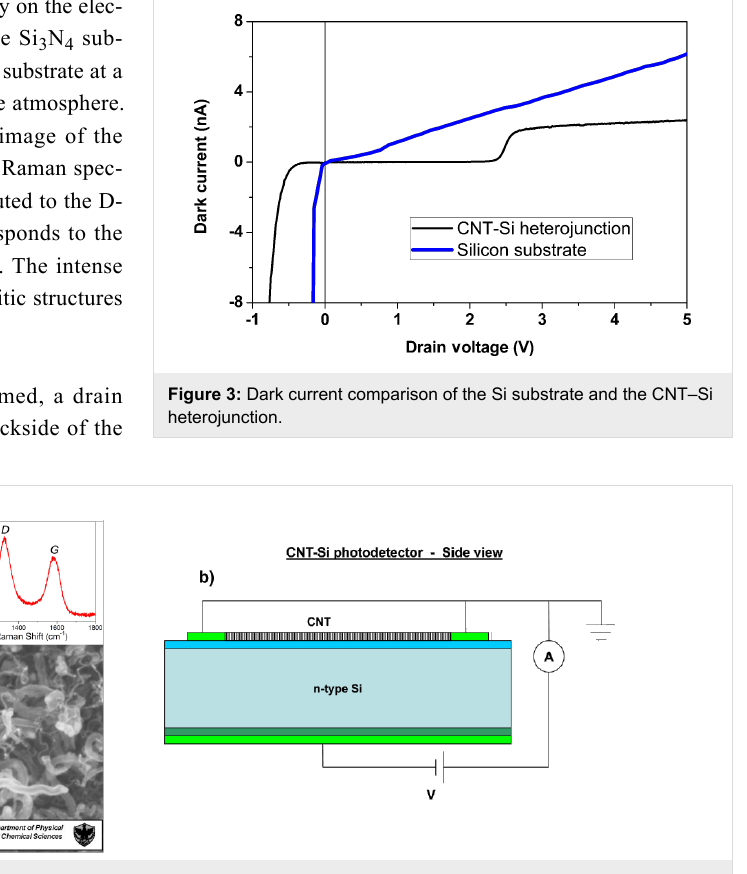
metallic guard ring, 1 mm wide, serves to inhibit superficial current dispersions during electrical measurements. In the bottom part of the silicon wafer, a thin n + implanted layer ensures ohmic contact between the silicon and the metallic Ti/Pt electrodes, covering the entire back surface (Figure 1b). Thus, the main differences between the FBK substrate used in this work and the substrate used in [13] are: the Si 3 N 4 insulation layer on the upper part of the Si is much thinner (60 nm instead of 140 nm), the different thickness of Si (300 μ m instead of 500 μ m), the different Si resistivity (3–12 Ω∙ cm instead of 40 Ω∙ cm) and the absence of a Si 3 N 4 insulating layer in the bottom part of the Si layer. Due to these differences, the results from this work are different from those obtained in earlier work reported in [13].